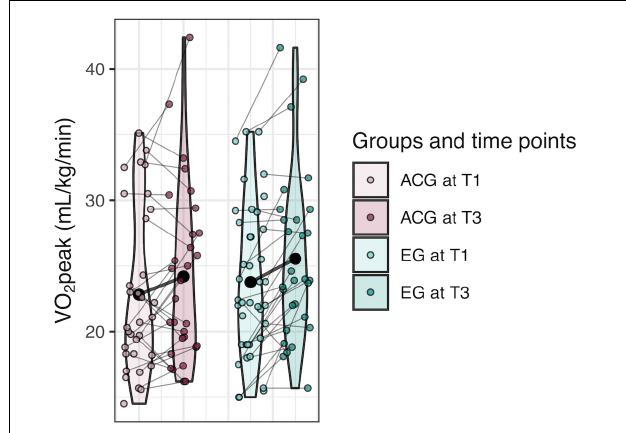
FIGURE 3 | Violin plots of VO 2 peak showing individual trajectories as well as mean change of cardiovascular fitness change over six months by group. T1, time point 1 (0 months); T3, time point 3 (6 months). Large black point represents group mean at each time